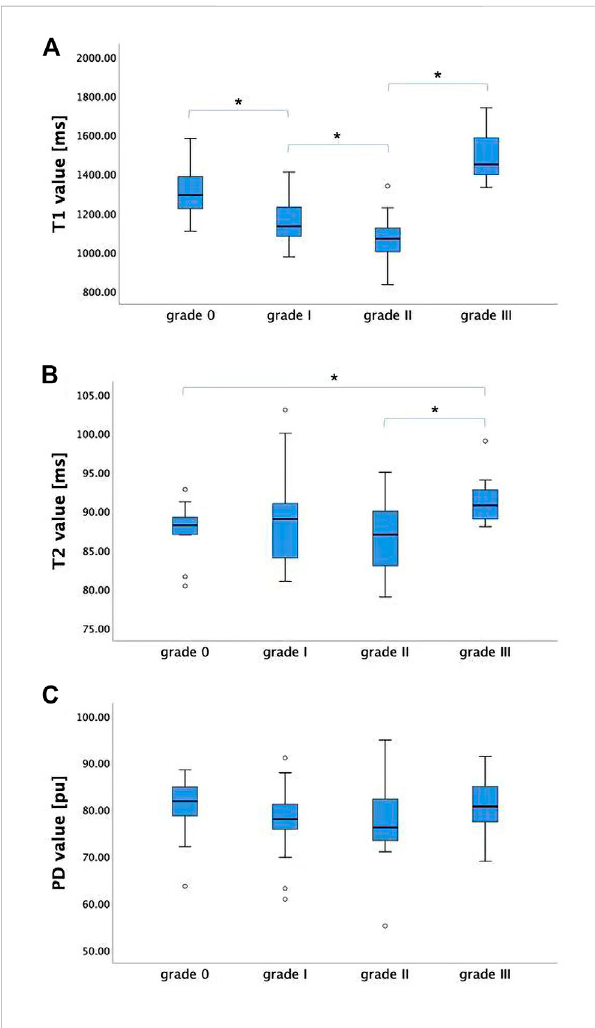
FIGURE 3 The T1, T2, and PD values (mean ± standard deviation) of grade 0-III groups. (A) T1 MCL value showed a decreasing trend with severity of grades (from grade 0 to grade II), while it increased dramatically at gradeIII. (B) T2 MCL valueshowednosigni fi cantdifferenceamong grade groups (from grade 0to grade II), while itincreased dramatically at grade III compared to grade II. (C) PD MCL value showed no statisticallydifferenceamongallgradegroups.*Statisticallysigni fi